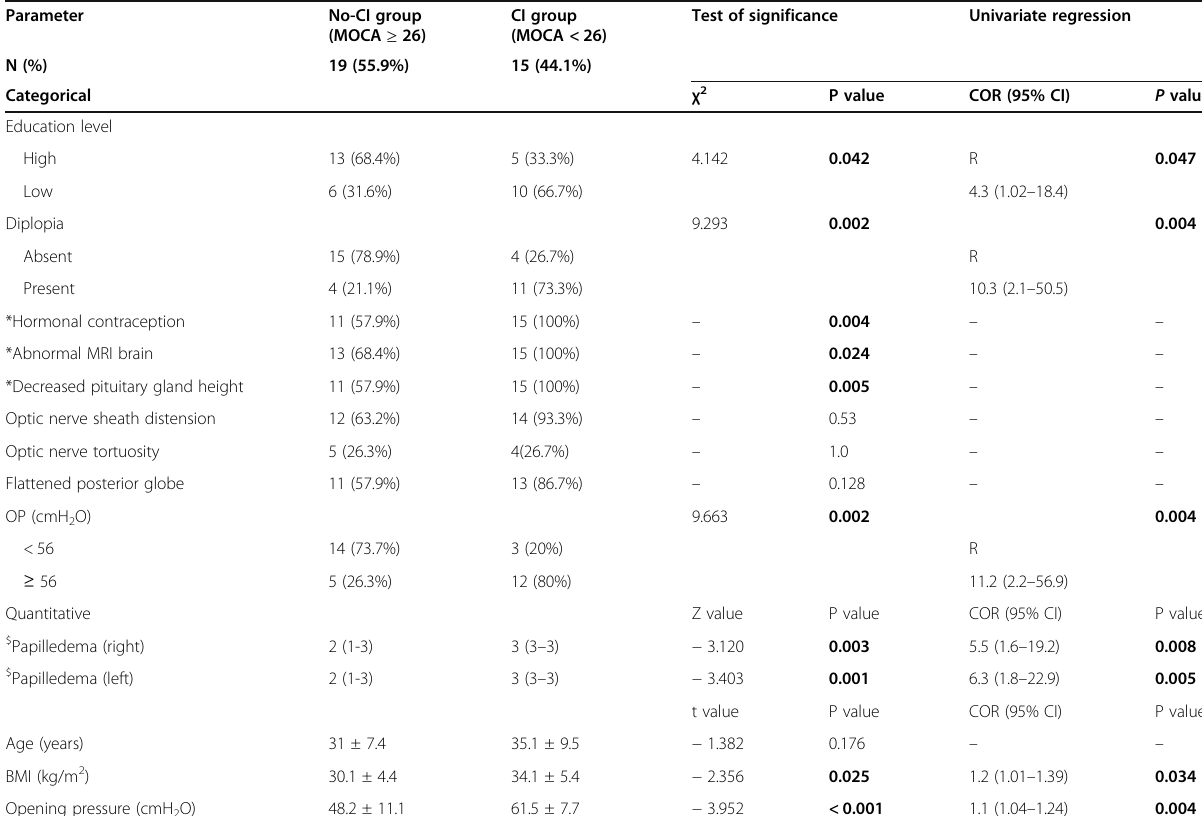
Table 7 Differences between those with and without cognitive impairment Parameter No-CI group